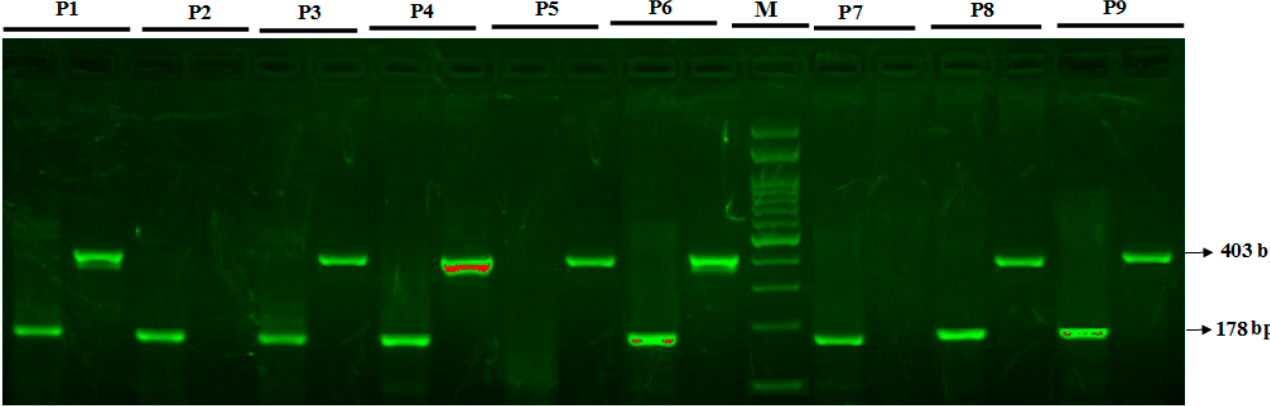
Figure 3. Detection of glyoxalase 1 genotyping, GLO-I rs2736654 C>A primers utilizing Allele